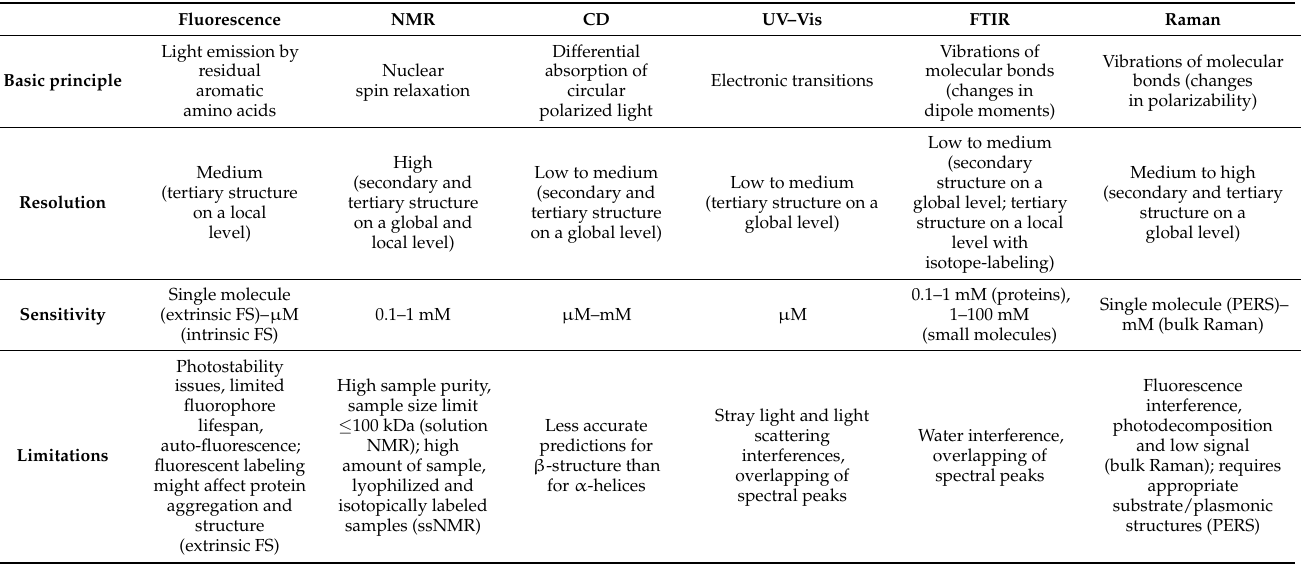
Table 1. Comparison between various spectroscopic